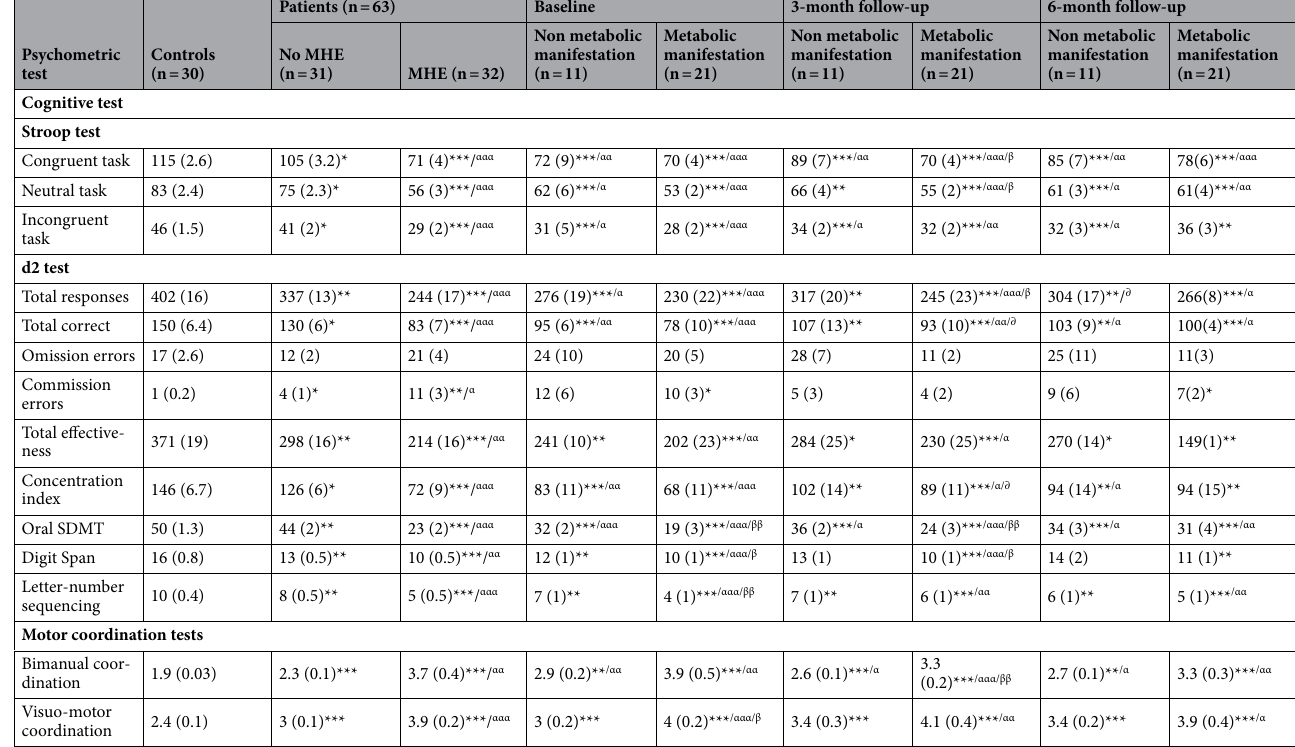
Table 4. Psychometric test performance at baseline and follow-up according to metabolic syndrome manifestations. All values are expressed as mean (SEM). *significant differences from controls (* p < 0.05; ** p < 0.01; *** p < 0.001). α significant differences from no MHE ( α p < 0.05; αα p < 0.01; ααα p < 0.001). β significant differences from patients without metabolic syndrome manifestations ( β p < 0.05; ββ p < 0.01; βββ p < 0.001). ∂ significant differences from baseline ( ∂ p < 0.05; ∂∂ p < 0.01; ∂∂∂ p < 0.001). Abbreviations: MHE and No MHE: patients with or without minimal hepatic encephalopathy,